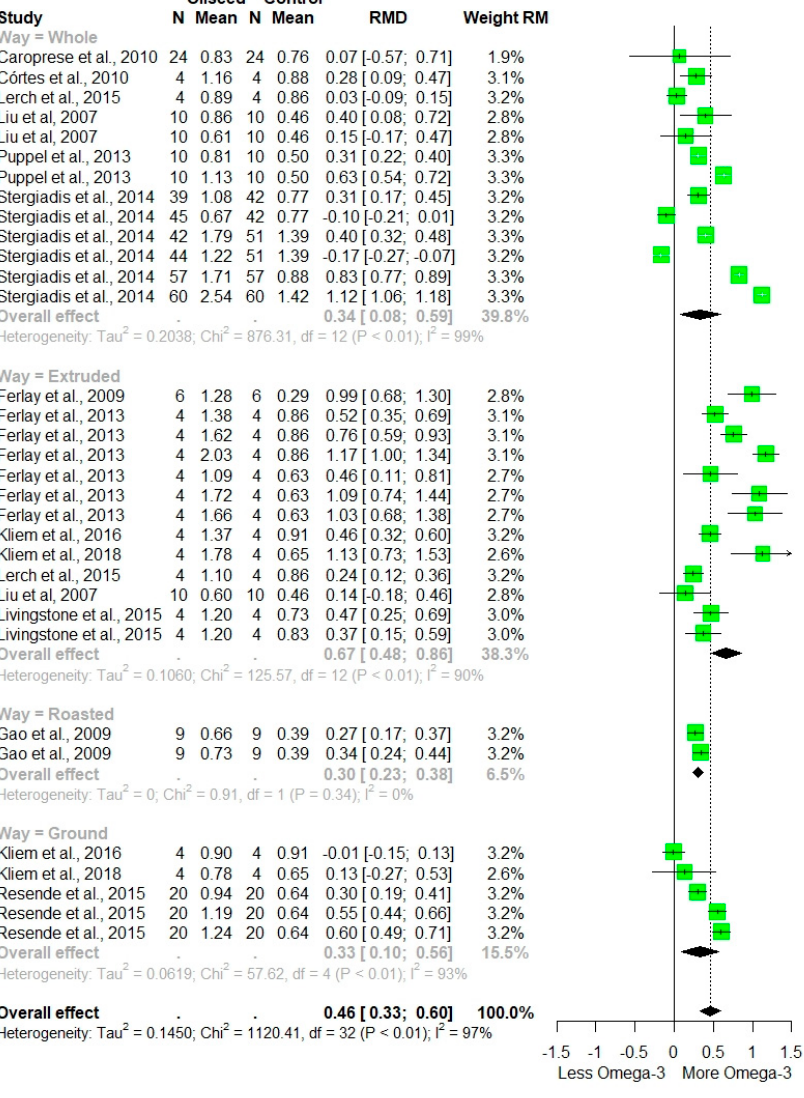
Figure 5. Forest plot of Σ omega-3 PUFA (g 100 g − 1 FA) for trials with the inclusion of oilseeds in dairy cow diets, grouped by oilseed processing. Point size reflects the relative weighting of the study to the overall effect size estimated, where a larger point size represents a greater weight and the combined effect size estimated, including the confidence intervals. The diamond represents the overall effect. RMD, raw mean difference.